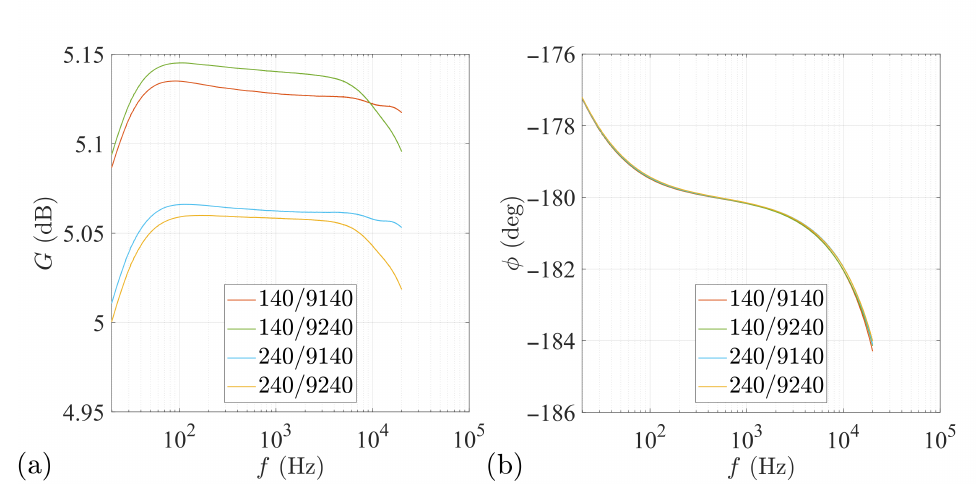
Figure 9. Measured: ( a ) amplitude and ( b ) phase characteristic of the LF amplifier.